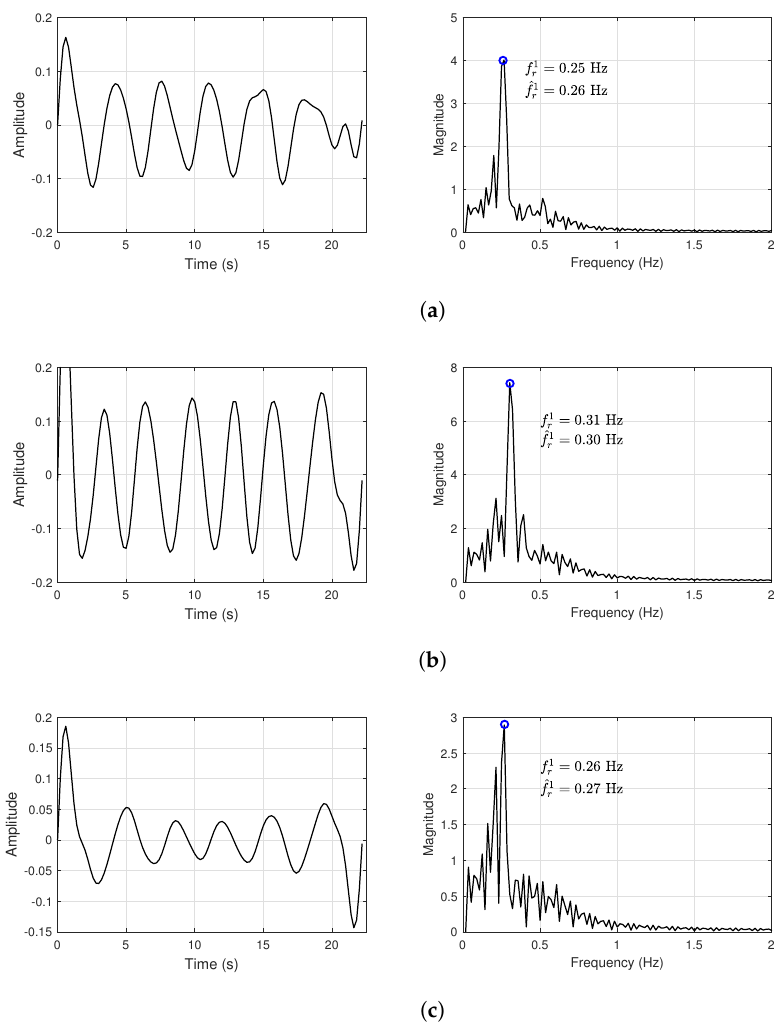
Figure 7. Estimated distance of one person at 1 m. ( a ) For θ 1 Using the beam focusing technique, the respiration rate was estimated with an error of 1.73%. Figure 8 shows the result of such a scheme for the first realization.